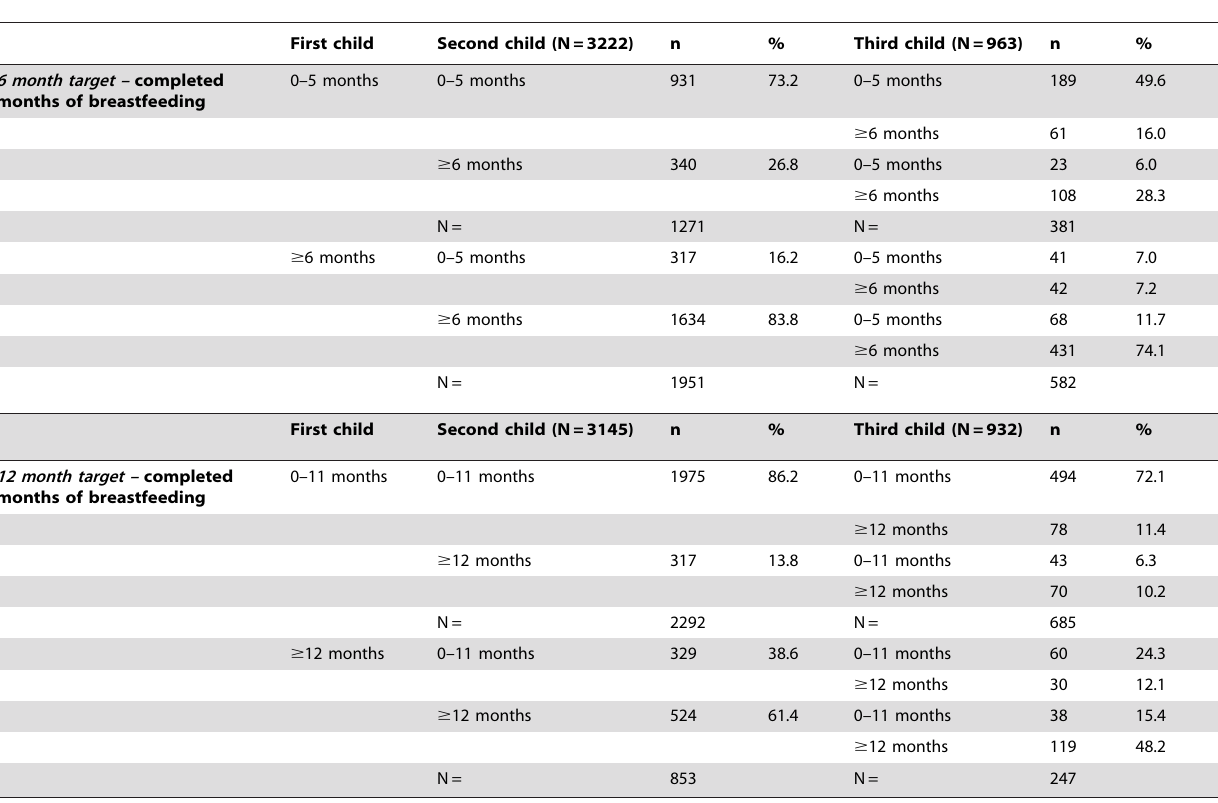
Table 3. Longitudinal patterns of breastfeeding duration a for women with two or more